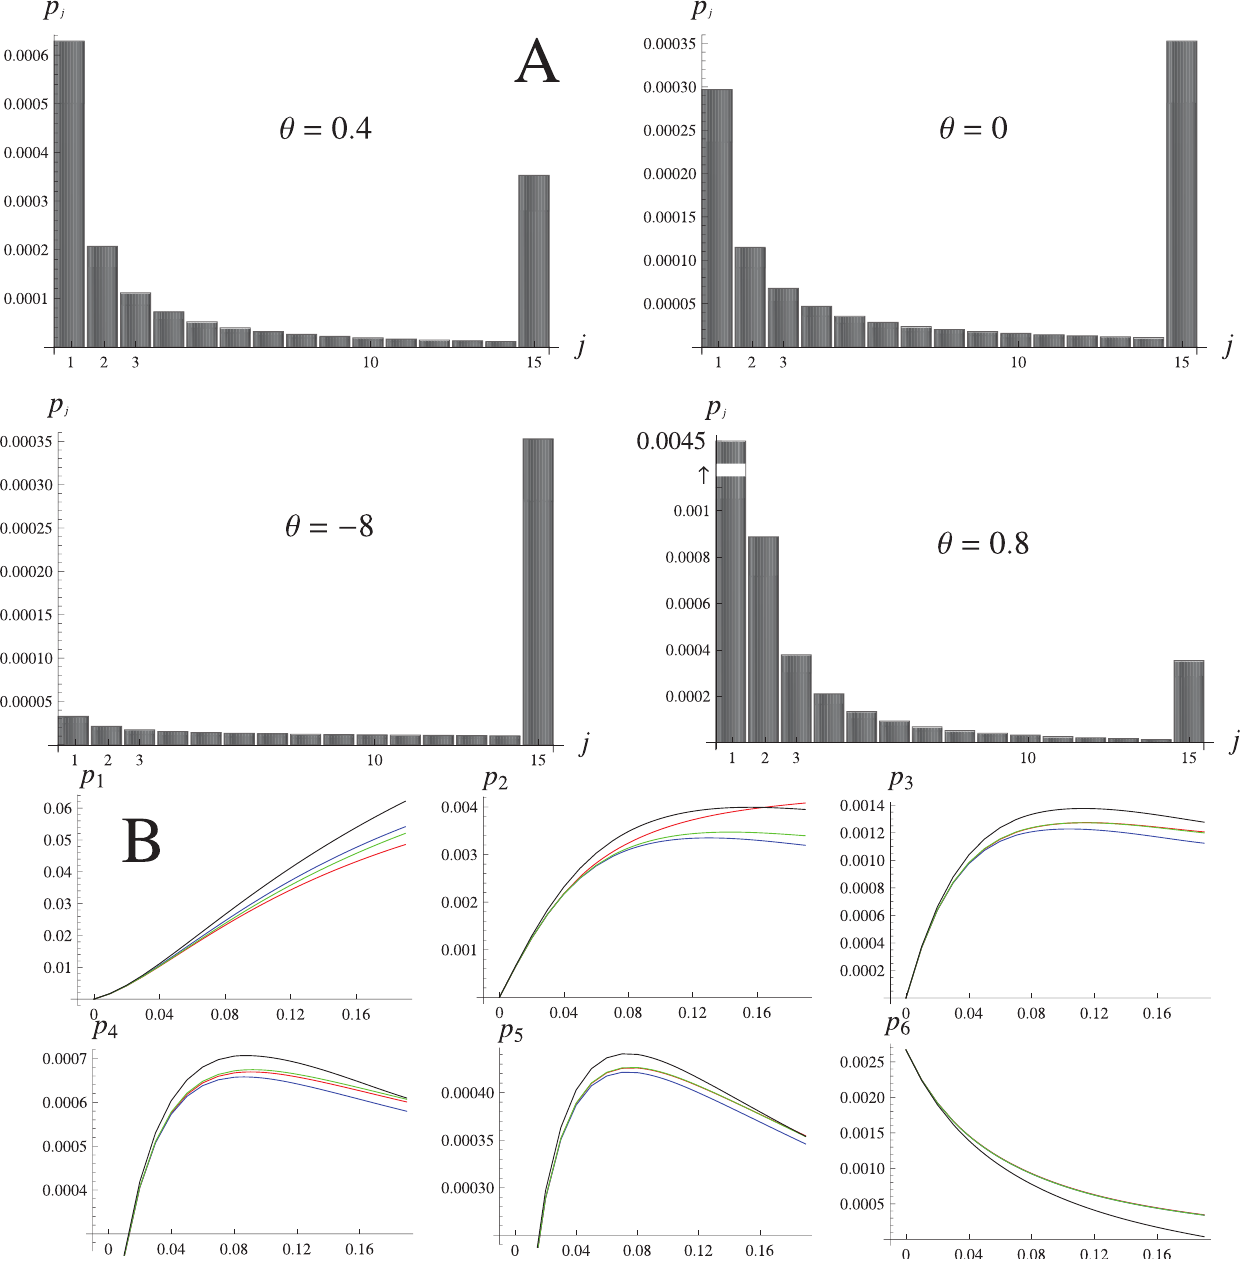
Figure 4. Distribution of the foreign genotype frequencies at the migration-selection equilibrium. A – Result of the introgression of the initial block composed of 15 genes, obtained through the Branching Process Approximation (BPA) by solving the Eqs (3) and (8–9) numerically. Note that the actual frequency of the single-gene blocks at h =0.8 is much higher than the corresponding bar height on the plot (indicated by the larger font on the Y-axis). B – Comparison of the frequency distributions, with the initial block composed of 6 genes, obtained through BPA (green line) against Panmictic Simulation (PS, red line), Introgressive Simulation (IS, blue line) and Single Crossover Simulation (SCS, black line) as the recombination rate ( r ) increases. For the simulation results to be comparable with the BPA, different genotypes were grouped together by the number of genes ( j ) they carry. Each plot represents variation in the frequency of the corresponding gene block (1–6). Parameter values are: S= 0.5, h =0.2, m